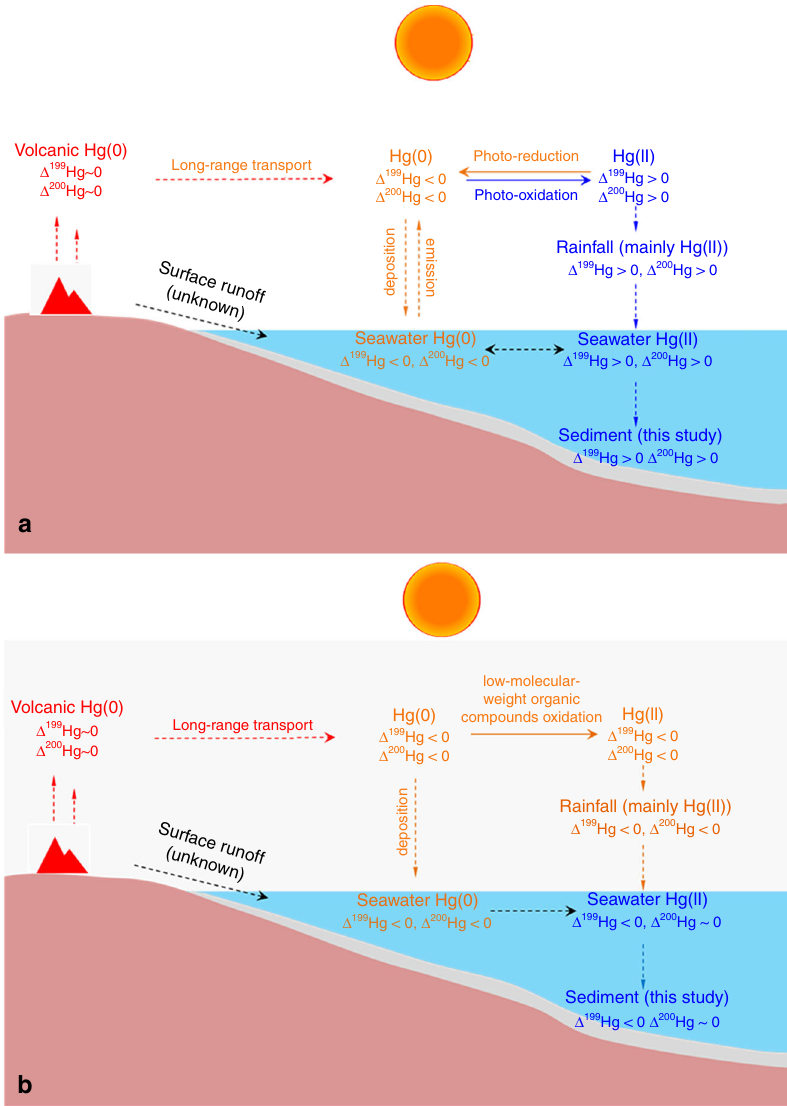
Fig. 5 Proposed scenarios for observed mercury isotope fractionation trends. a Intense photochemical reactions in the absence of an ozone layer lead to the production of large Hg-MIF in the Archean atmosphere. The red color represents volcanic Hg(0), which has been the primary source of Hg to the Earth surface over geologic time. This volcanic Hg(0) is characterized by Δ 199 Hg ~0 ‰ and Δ 200 Hg ~0 ‰ , and can undergo long-range transport in the atmosphere. Atmospheric Hg(0) was oxidized to gaseous Hg(II), and a fraction of that Hg(II) was photoreduced back to Hg(0). These photochemical processes produced gaseous Hg(0) with negative Δ 199 Hg and Δ 200 Hg values, and gaseous Hg(II) with positive Δ 199 Hg and Δ 200 Hg values. The orange color represents the deposition of gaseous Hg(0) to ocean surface and the reemission to the atmosphere. The light blue color represents the deposition of gaseous Hg(II) through precipitation, the scavenging of seawater Hg (mainly precipitated Hg(II)) by organic particles, and the burial of organic-bound Hg with mainly positive Δ 199 Hg and Δ 200 Hg signals in marine sediments. b In the presence of a hydrocarbon haze, nearly all Hg(0) was oxidized by low molecular weight organic compounds before deposition, scavenging, and burial. The red color represents volcanic Hg(0), which was mixed with background atmospheric Hg(0) carrying negative Δ 199 Hg and Δ 200 Hg values. The orange color represents nearly complete oxidation of Hg(0) to Hg(II), and therefore the deposited Hg(II) is characterized by negative Δ 199 Hg and Δ 200 Hg values. The light blue color represents the mixing of the deposited atmospheric Hg(II) with seawater Hg that is characterized with positive Δ 199 Hg and Δ 200 Hg values. The scavenging and the burial of these two forms of Hg produced marine sediments with slightly negative Δ 199 Hg and near zero Δ 200 Hg